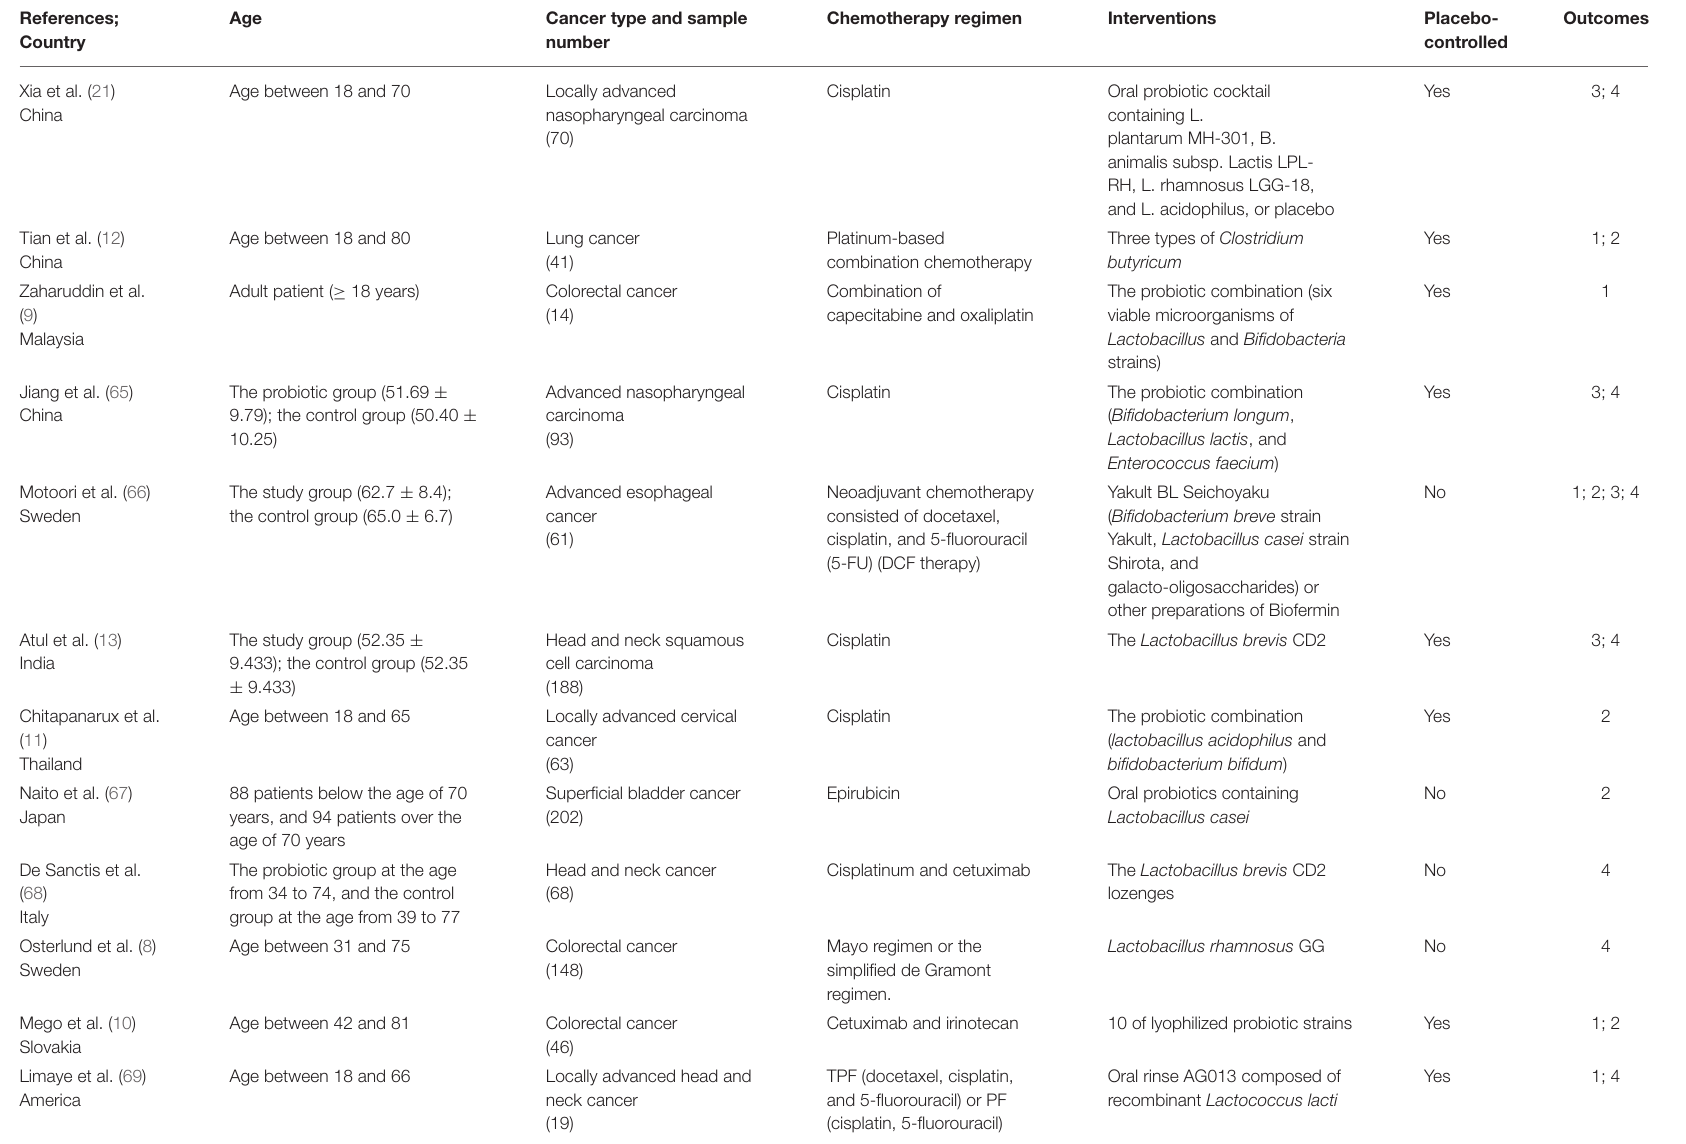
TABLE 1 | Characteristics of the included